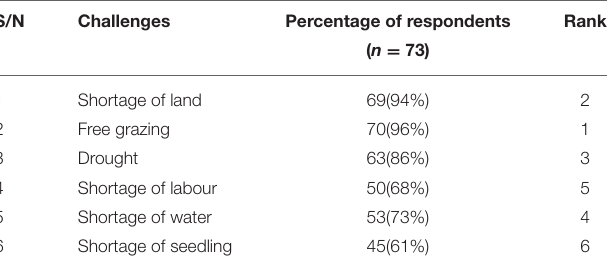
TABLE 6 | Main Constraints in agro-forestry management.